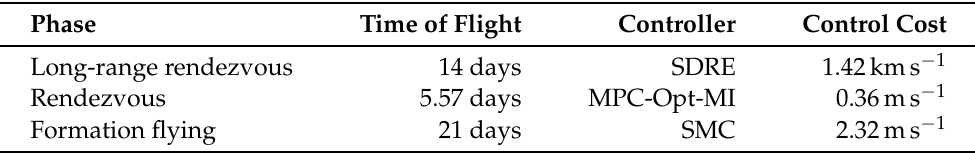
Table 9. Phase metrics for the Gateway resupply